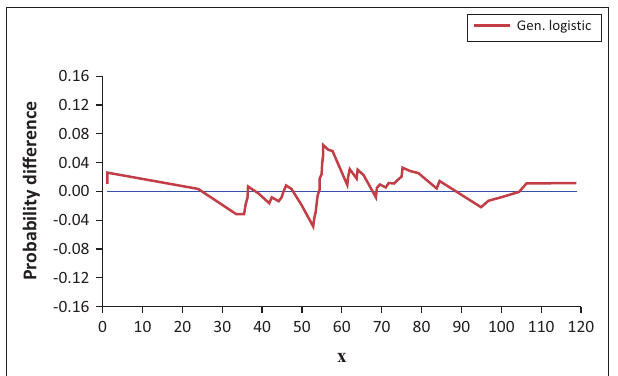
FIGURE 6: Probability–difference plot between empirical continuous probability distribution function and generalised logistic probability distribution